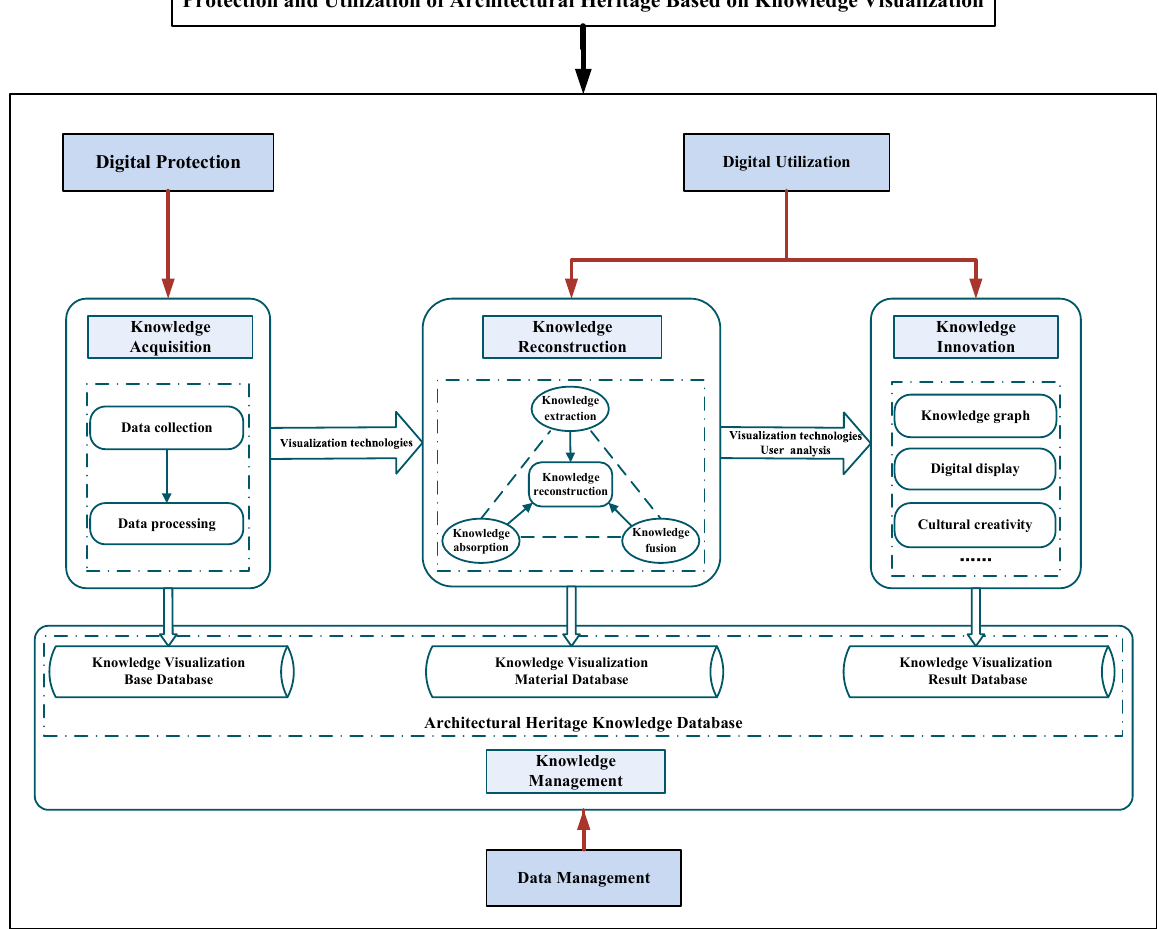
Figure 1. General technical framework of this study.